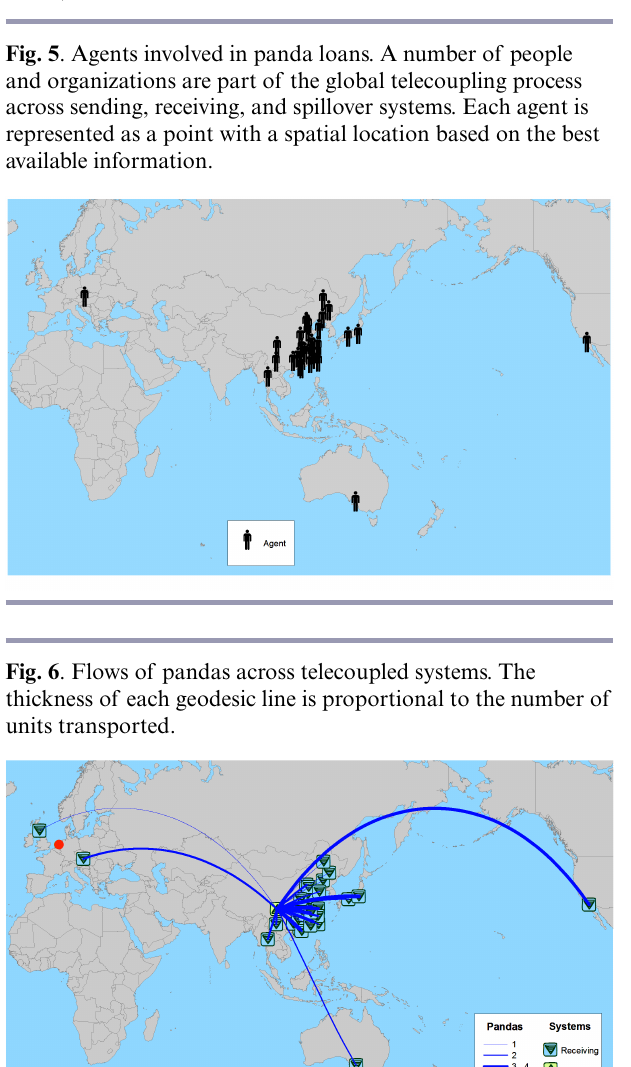
Fig. 5 . Agents involved in panda loans. A number of people